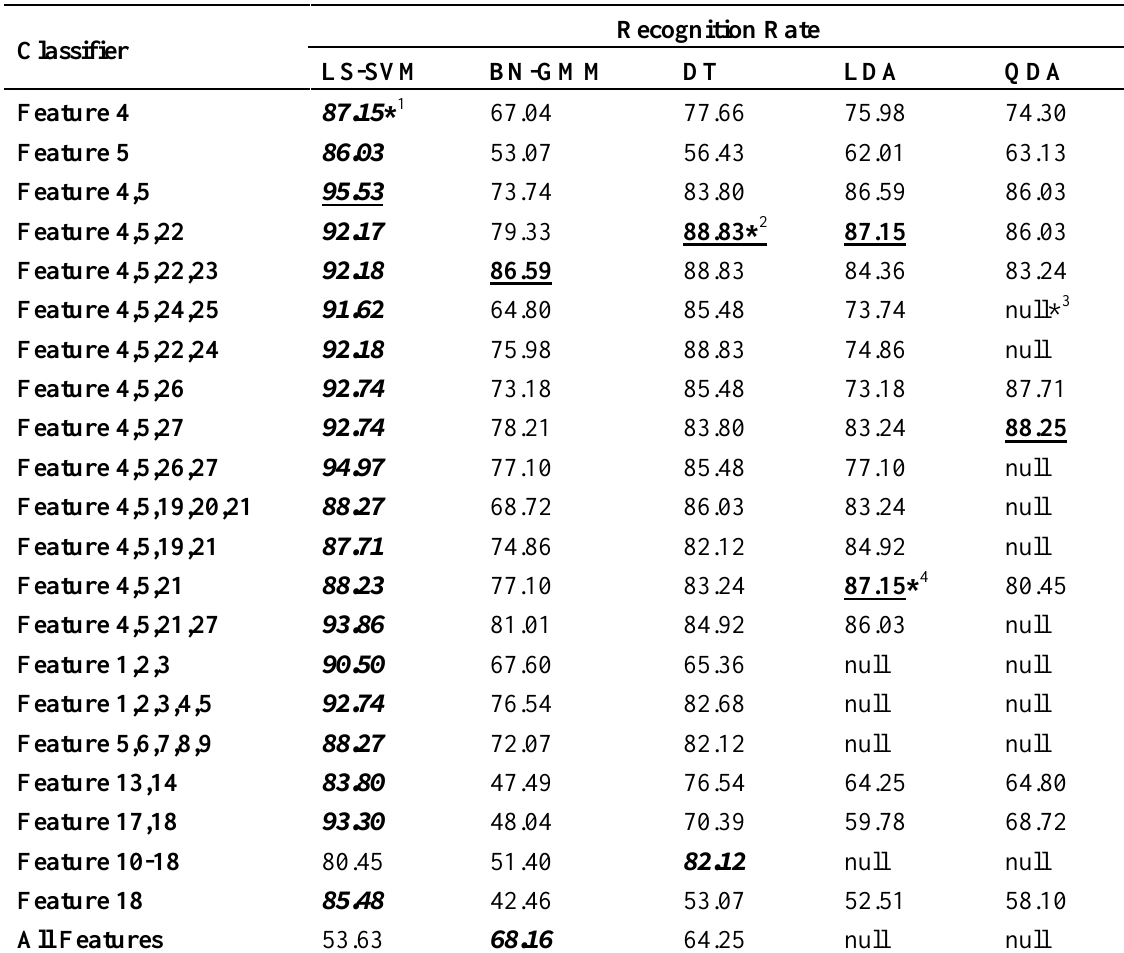
Table 3. Classifier vs. Recognition Rate vs.